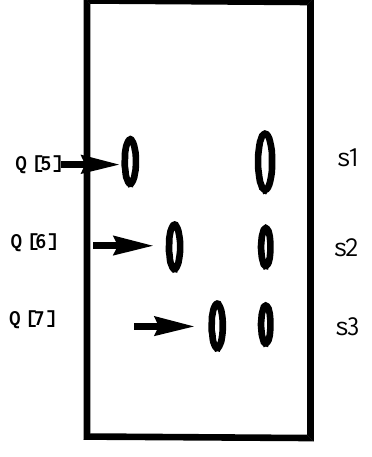
as a visualization 2